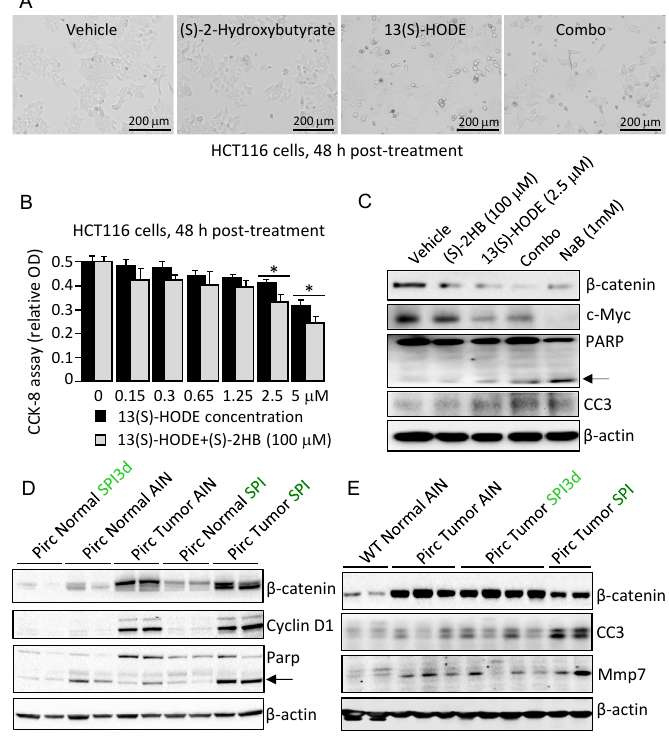
Figure 7. Apoptosis induction is observed by 13(S)–HODE, (S)–2HB, and spinach. ( A ) Morphology, ( B ) viability (mean ± SD, n = 3, * p < 0.05 by Student’s t -test) and ( C ) apoptosis endpoints in HCT116 cells treated for 48 h with 100 µ M (S)–2HB, 2.5 µ M 13(S)–HODE, or 100 µ M (S)–2HB plus 2.5 µ